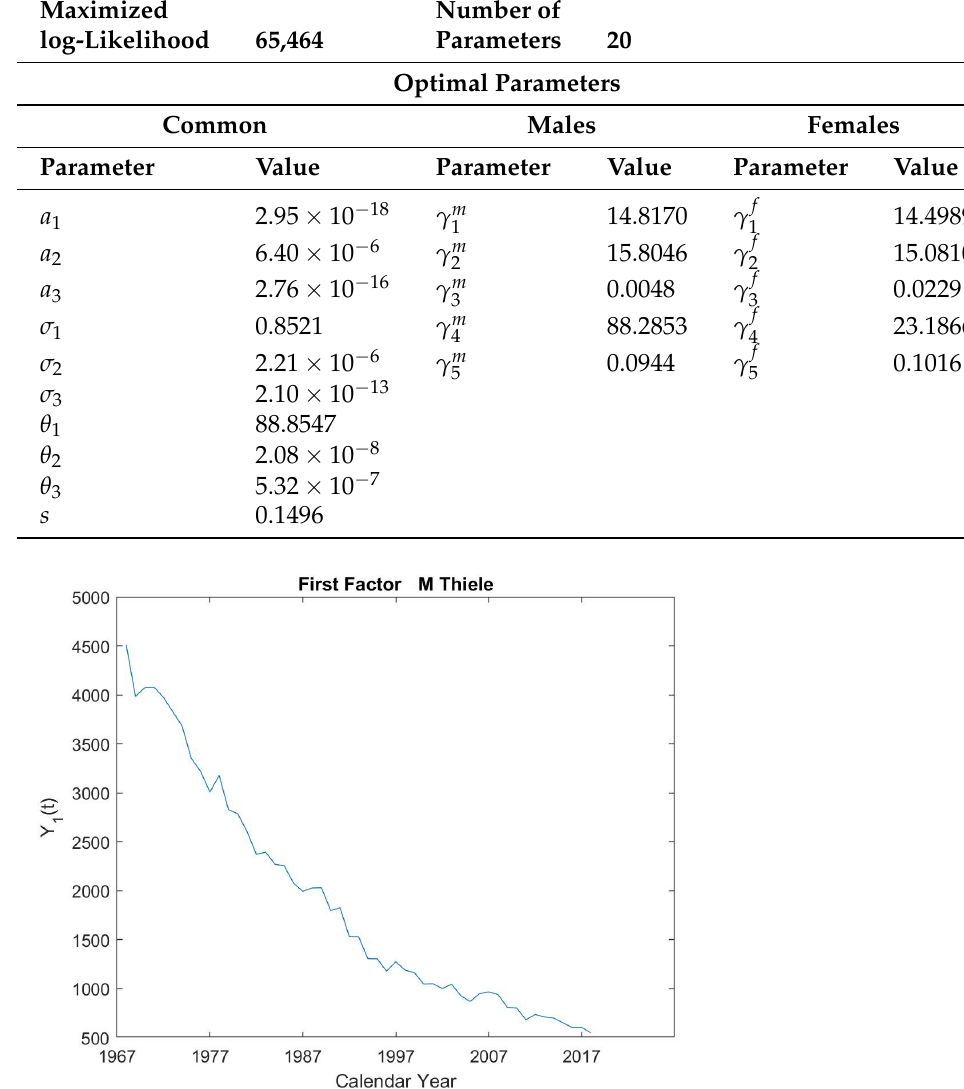
Table 2. This table collects the optimal parameters for our model and is divided in two panels, one for each population. For each population, the ”common” column collects the parameters relative to the factor processes and the measurement variance covariance matrix s . The other two columns collect the parameters relative to the response functions of the two sub-populations of males and females.